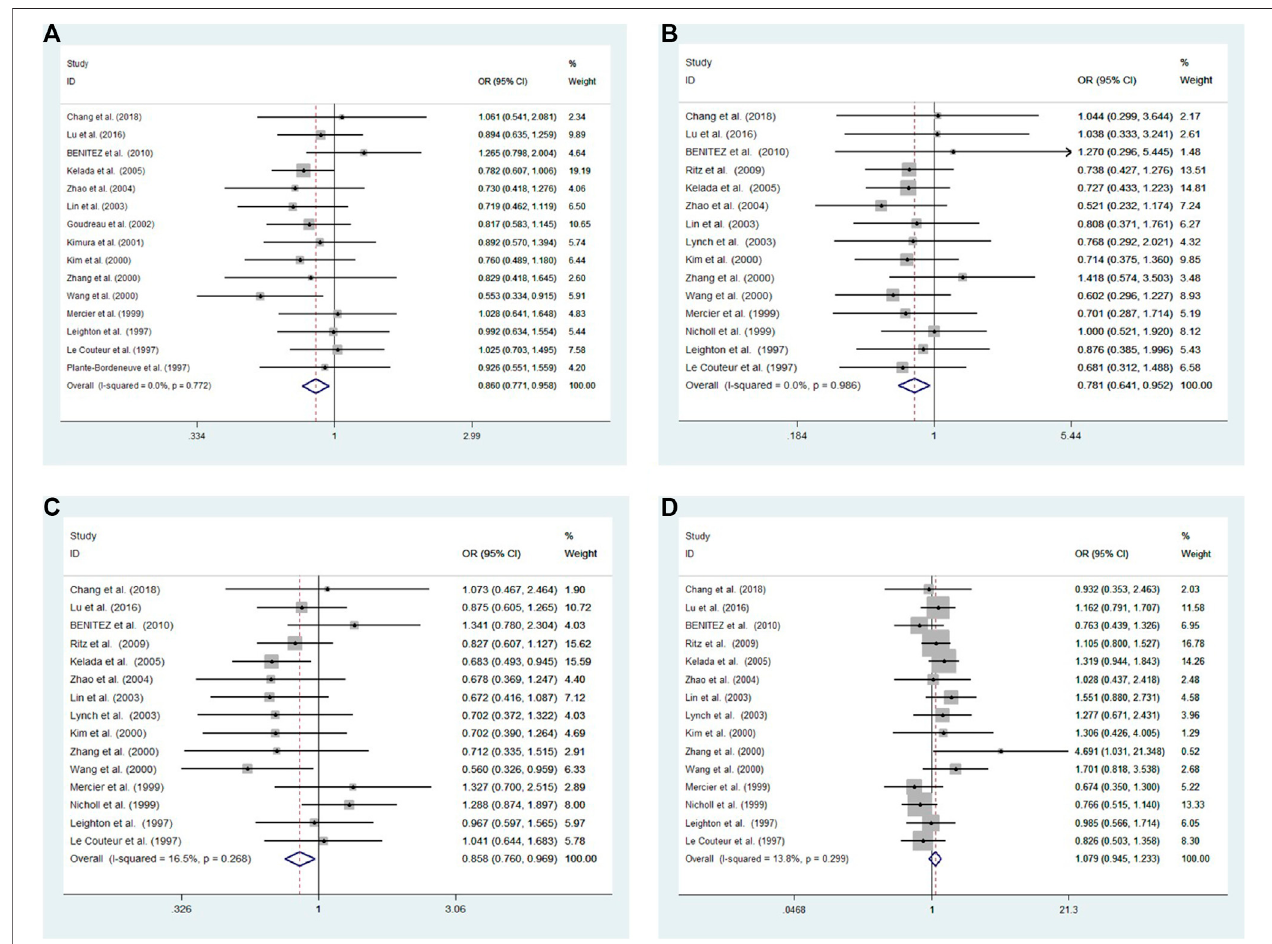
FIGURE 2 | Meta-analysis with a fi xed effects model for the association between the 3 ′ -UTR VNTR in SLC6A3 and PD susceptibility. (A) Allele model, 10R vs. all others (B) Pseudodominant model, 10R/10R + 10R/9R vs. all others (C) Pseudorecessive model, 10R/10R vs. all others (D) Pseudocodominant model, 10R/9R vs. all others OR: odds ratio, CI: con fi dence interval, I-squared: measured to quantify the degree of heterogeneity in meta-analyses.